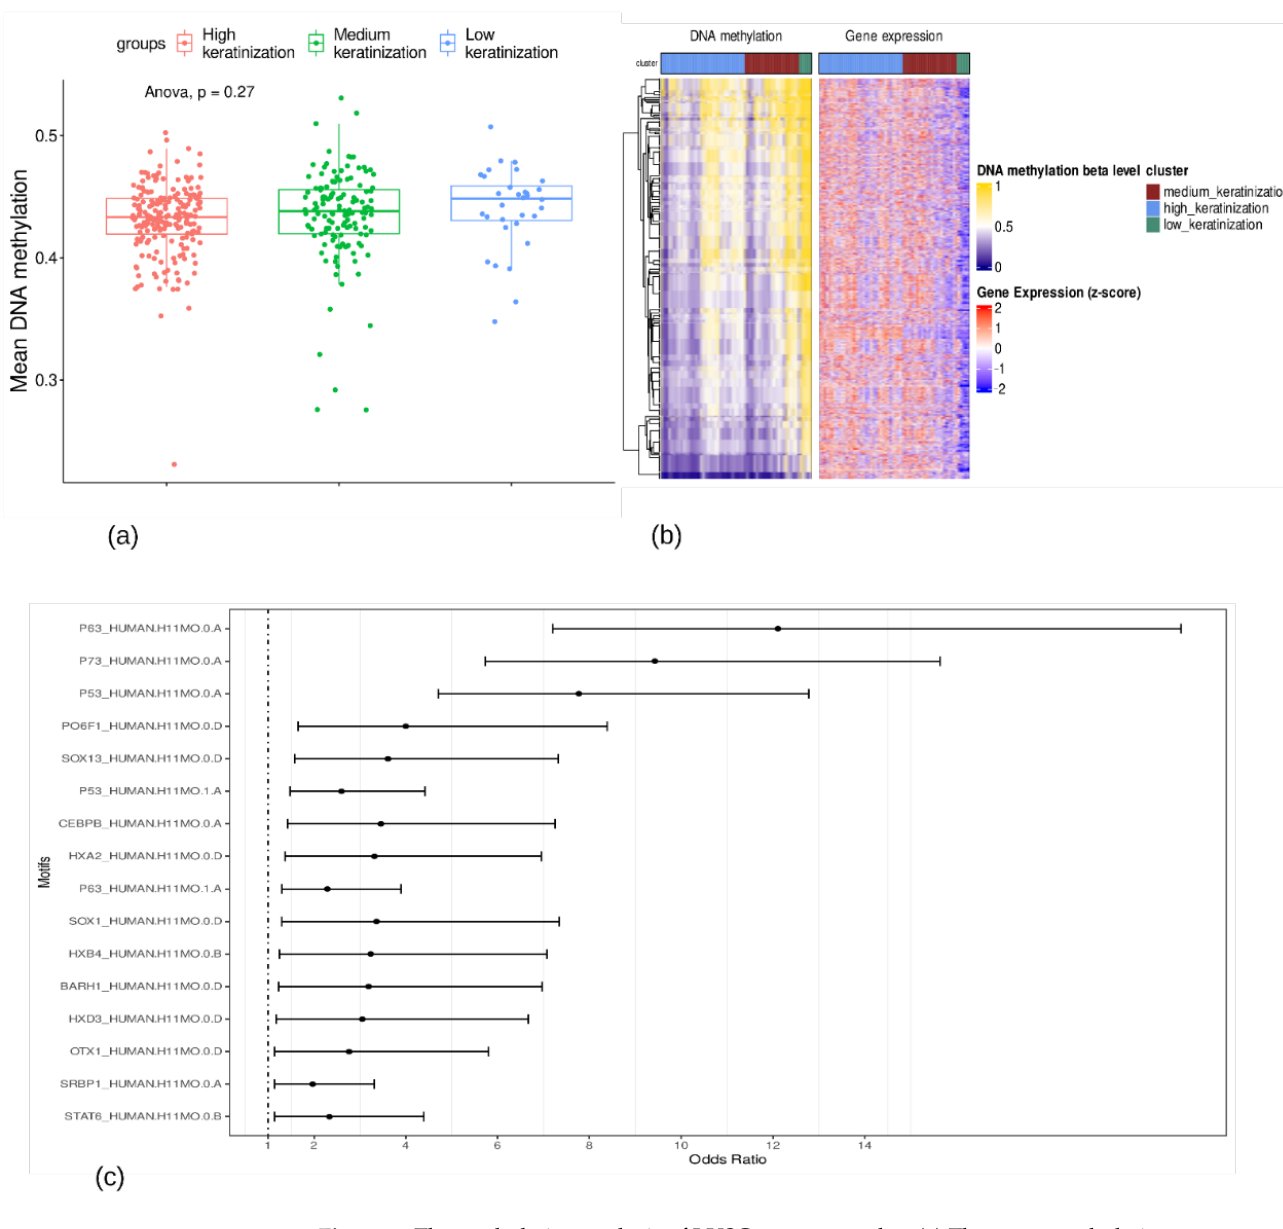
Figure 4. The methylation analysis of LUSC tumor samples. ( a ) The mean methylation status across three groups. ( b ) The methylation levels of the significant gene-probe pairs. The rows and columns in DNA methylation heatmap represent the probes and samples, respectively. The rows and columns in gene expression heatmap represent the corresponding genes and samples. ( c ) The enriched binding motifs for the probes that are significantly hypomethylated in high keratinization samples relative to low keratinization samples.